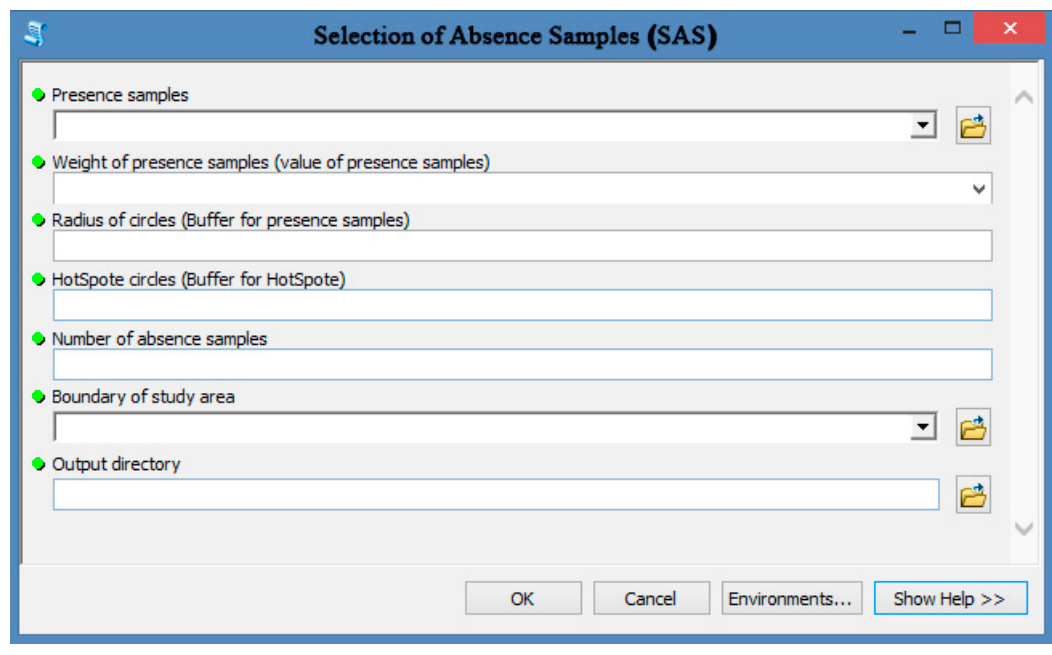
Figure 4. A view of the Selection of Absence Samples (SAS) tool and its components. Table 1. Input parameters and files for the Selection of Absence Samples (SAS) tool.